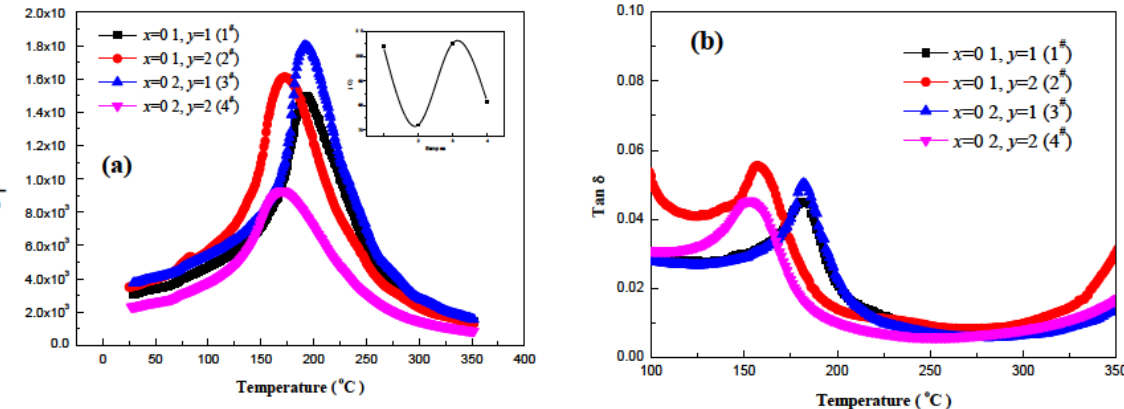
Figure 3: Temperature dependence of (a) ϵ r and (b) tan δ of PNN-PZT ceramics with different contents of CuO and LiBiO 2 measured at 100